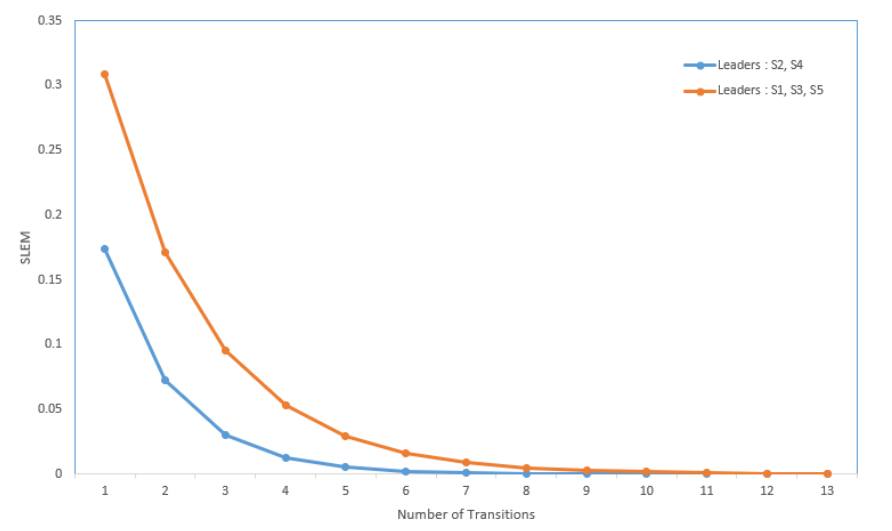
Figure 3. Improvement in convergence rate due to suitable selection of leader